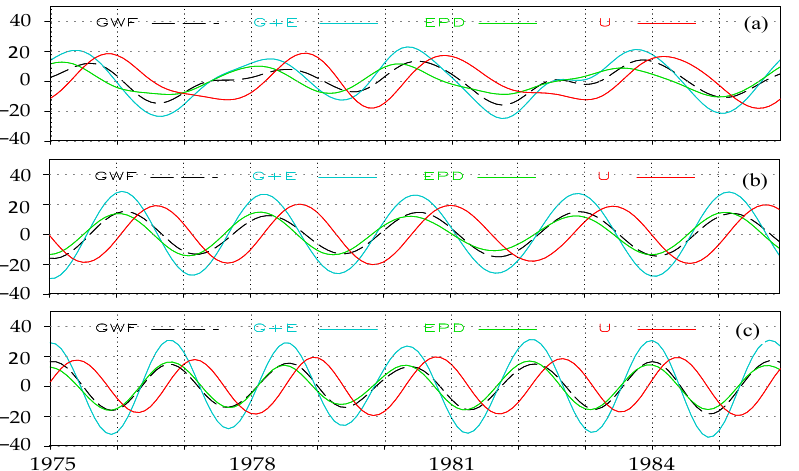
Figure 11. QBO components of zonal–mean zonal wind (red) and forcings (parameterized gravity wave forcing (GWF, black dash-line), resolved wave forcing (EPD, light green), and combined forcing (G + E, cyan)) at 20 hPa for the ( a ) P, ( b ) ST, and ( c ) N runs from 1975 to 1985. All the quantities are averaged between 10° S and 10° N. Units are in ms − 1 for wind, and 10 − 2 ms − 1 day − 1 for forcings.